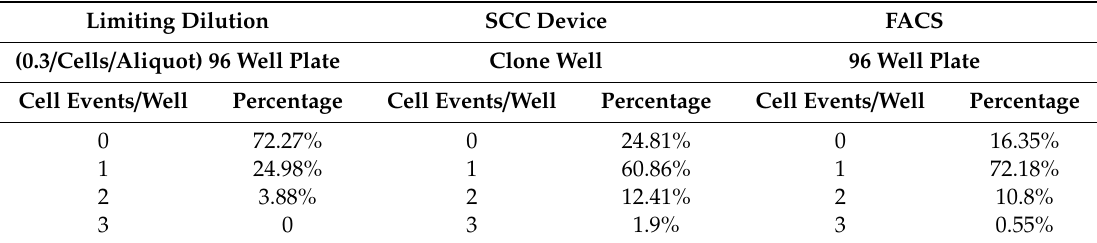
Table 1. Comparison of cell events per well after single-cell isolation by limiting dilution, single-cell cloning (SCC) device, and fluorescence-activated cell sorting (FACS). In limiting dilution, 0.3 cells / aliquot were seeded into 96-well plates. The SCC device has a higher single-cell capture e ffi ciency than limiting dilution. Although lower than that of FACS, it is still an advanced method for single cell per well event validation. Limiting